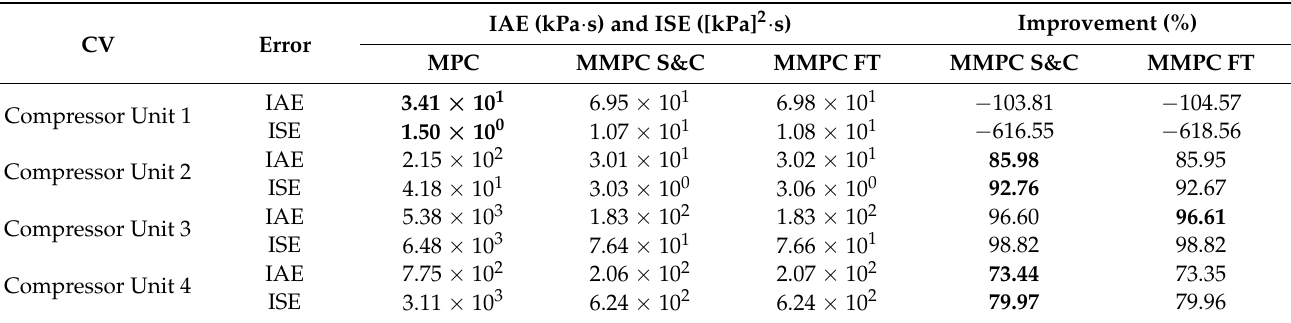
Table 10. Comparison of IAE and ISE on the compressor unit with changes on compressor unit 4 (MIMO Model